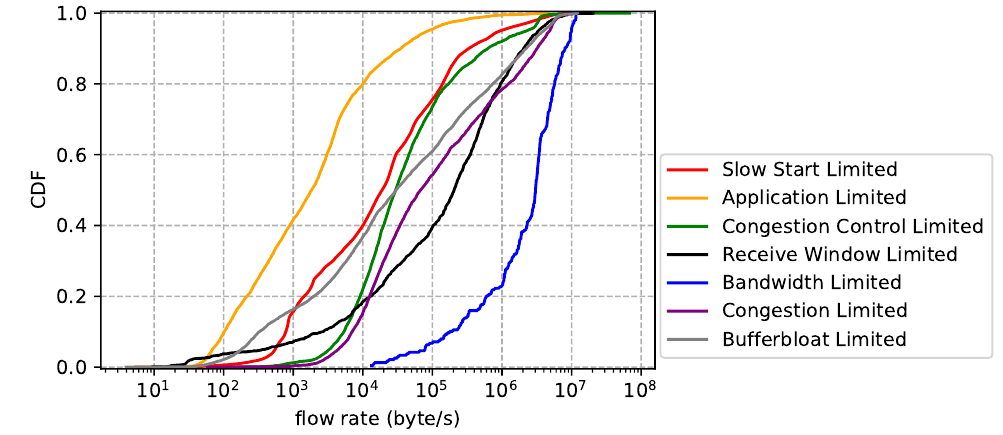
Figure 12. Flow duration distribution for each limiting factor (CDN trace).